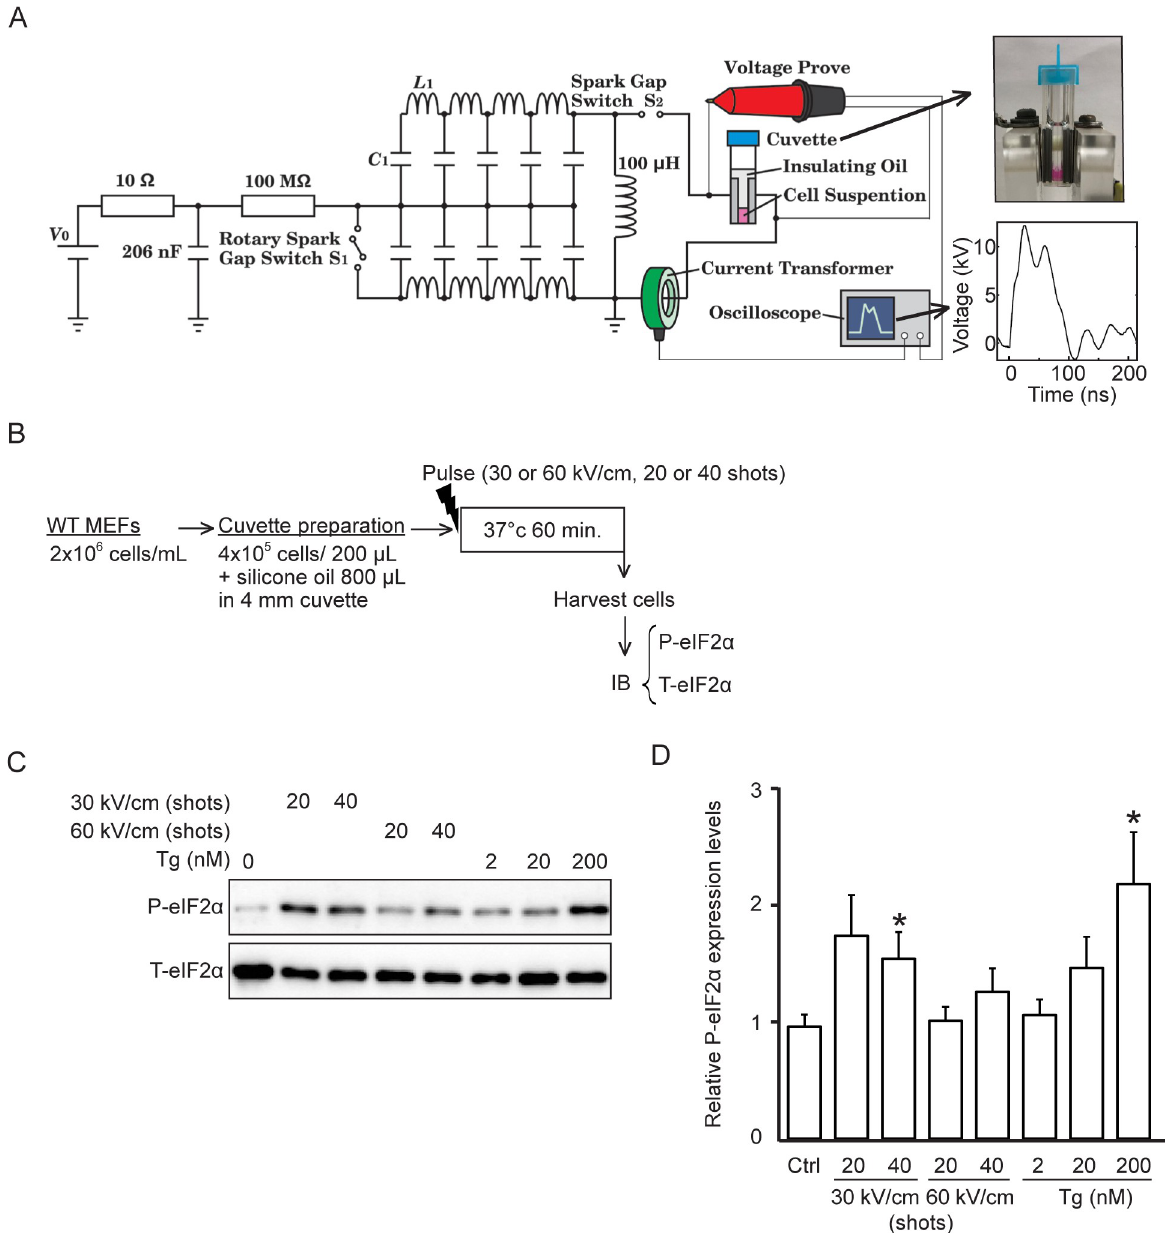
Fig 1. Phosphorylation of eIF2 α is induced in WT MEF cells by 40 shots of nsPEFs with 70-ns duration and 30-kV/cm electric fields. ( A ) The circuit configuration of the B-PFN as an nsPEF generator. The right upper panel shows a photograph of the nsPEF delivery device with a 4-mm gap cuvette. The right lower panel shows typical waveforms of nsPEFs using a 4-mm gap cuvette. ( B ) Experimental protocol. Resuspended WT MEF cells (4 x 10 5 ) were loaded into a 4-mm gap cuvette and covered with 800 μ L silicone oil. After the indicated nsPEF treatment, WT MEF cells were collected into a 1.5-mL tube and incubated at 37˚C for 1 h followed by immunoblot analysis. ( C ) Representative immunoblots of phosphorylated eIF2 α and total eIF2 α in WT MEF cells 1 h after the indicated nsPEF treatment. An ER stressor Tg served as a positive control for eIF2 α phosphorylation. ( D ) Densitometry quantification of phosphorylated eIF2 α normalized to the total eIF2 α level in WT MEF cells 1 h after the indicated nsPEF treatment. Error bars show the means ± SEM ( n = 8, � P < 0.05).